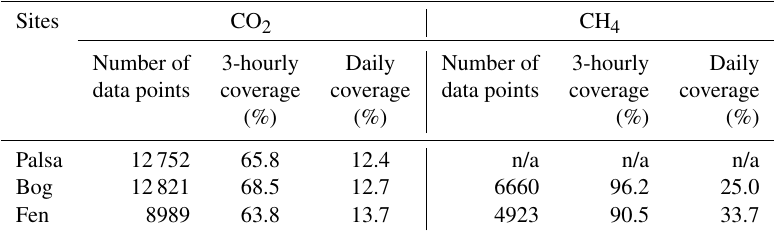
Table 1. Temporal coverage of quality-controlled CO 2 and CH 4 exchanges measured by automated chambers in the three peatland types in the Stordalen Mire during the years 2002 to